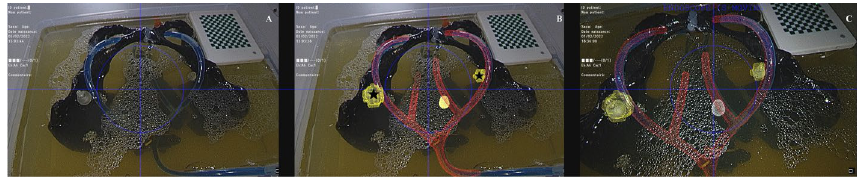
Fig. 6 Registration of SPECT/CT and CT. Laparoscopic view of the pelvic anatomy on phantom model ( A ) enhanced by real-time AR overlay of SLNs and anatomical landmarks, with SLNs marked with a black asterisk on the left and right ( B ) and in higher magnification to assess the overlay of the registration on anatomical structures and its performance ( C ). SPECT/CT, single-photon emission computed tomography combined with computed tomography; CT, computed tomography; SLN, sentinel lymph node